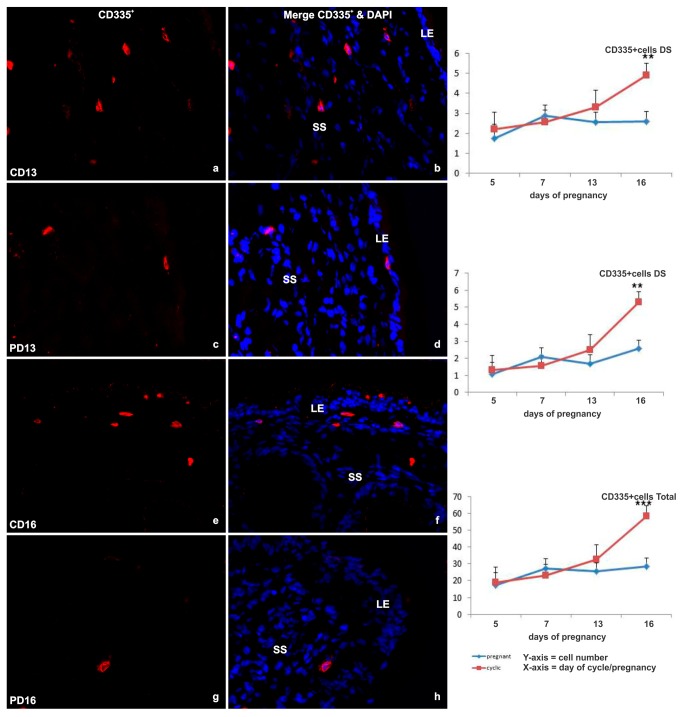
Immunofluorescent labeling of endometrial tissue for NK cells.(a-h) Representative images of immunofluorescent CD335+ NK cell receptor labeling (red) in cells (nuclei labeled with DAPI [blue]) of the endometrial SS from cyclic (C) and pregnant (P) heifers on Days 13 and of the deep stroma (DS) from C and P heifers on day 16 (original magnification ×40). B) Line graphs detailing the total number of NK cells in cyclic (red line) and pregnant (blue line) endometrial tissue based on the sum of immunofluorescent labeled cells per 2.25 mm2 field of view, in all areas (total CD335+) ) and specifically in the luminal epithelium (LE), shallow stroma (SS) and in the deep stroma (DS). Values plotted are least squared means and standard errors across across 5 replicate animals per timepoint and per status.